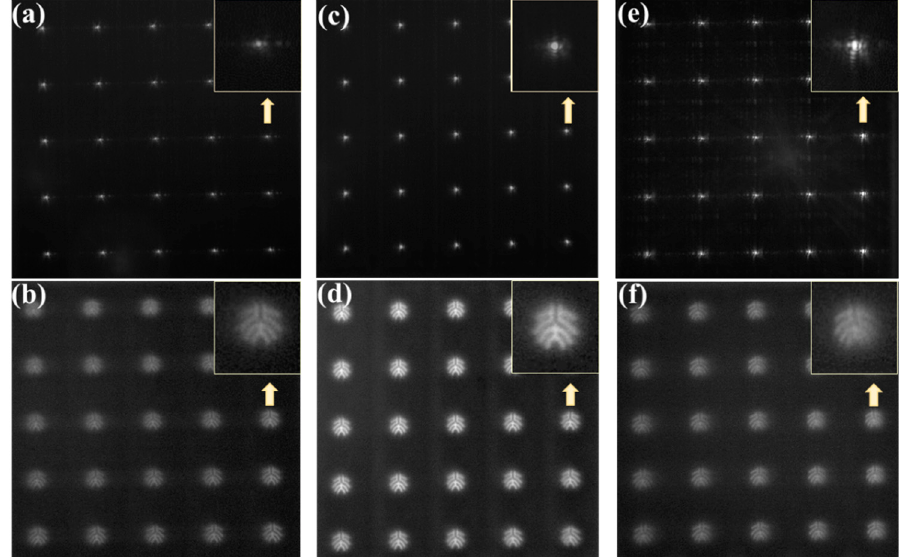
Figure 7. ( a ) Foci of the unannealed 5 × 5 lens array; ( b ) The image of the logo from the unannealed 5 × 5 lens array; ( c ) Foci of the 5 × 5 lens array annealed at 120 °C; ( d ) The image of the logo from the 5 × 5 lens array annealed at 120 °C; ( e ) Foci of the 5 × 5 lens array annealed at 130 °C; ( f ) The image of the logo from the 5 × 5 lens array annealed at 130 °C. The insets show the enlarged one of the images indicated by the arrows.